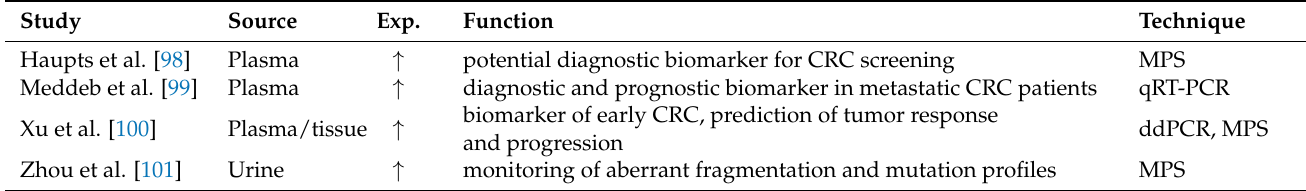
Table 4. List of cf-mtDNA copy number changes in